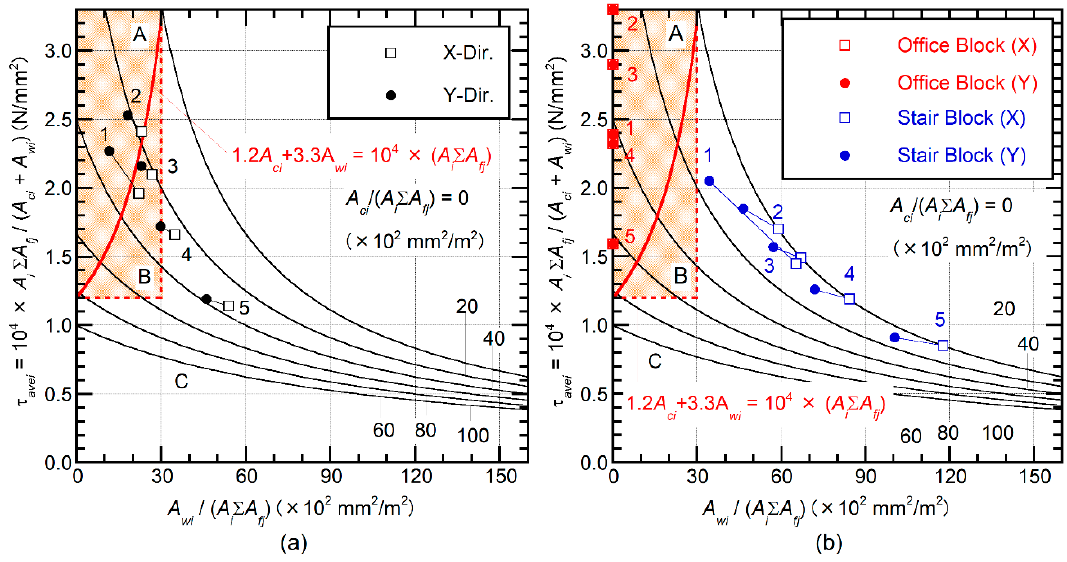
Figure 8. Preliminary seismic capacity evaluation results of the main building of the Uto City Hall [2]: ( a ) the case in which the building is assumed to behave as a unite building, and ( b ) the case in which the stair and office blocks are assumed to behave independently.